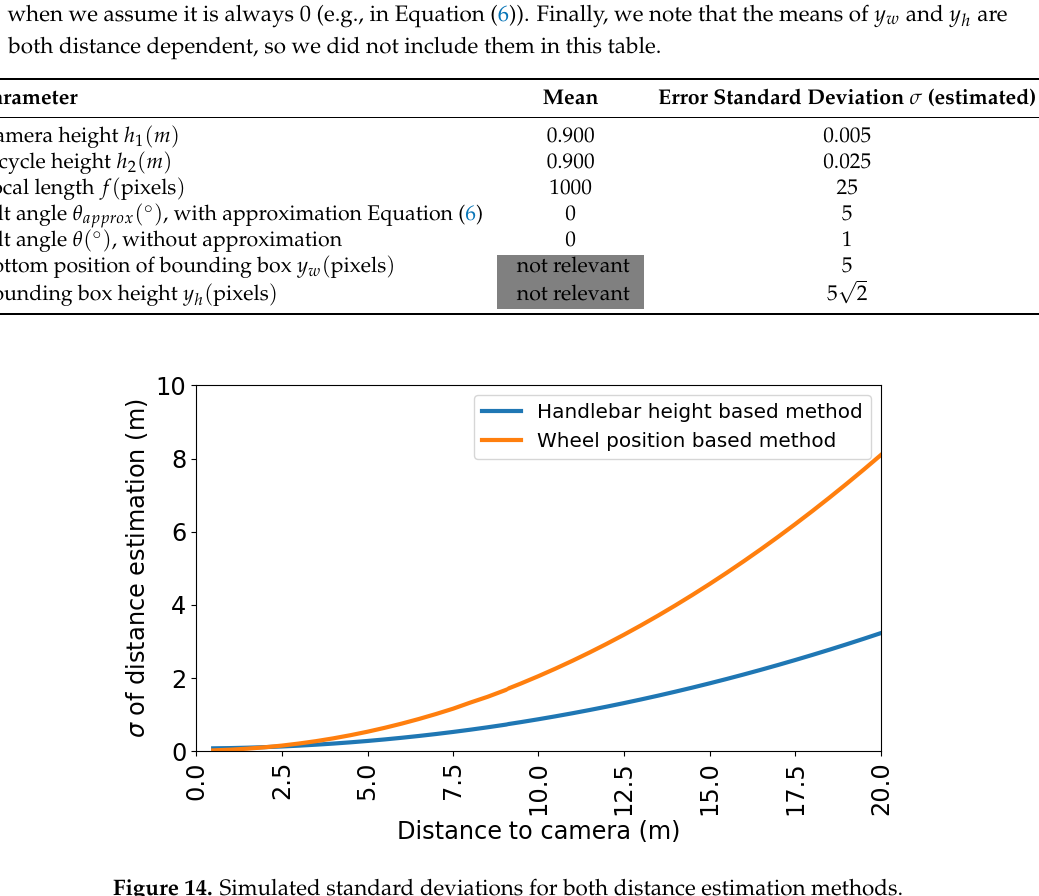
Figure 14. Simulated standard deviations for both distance estimation